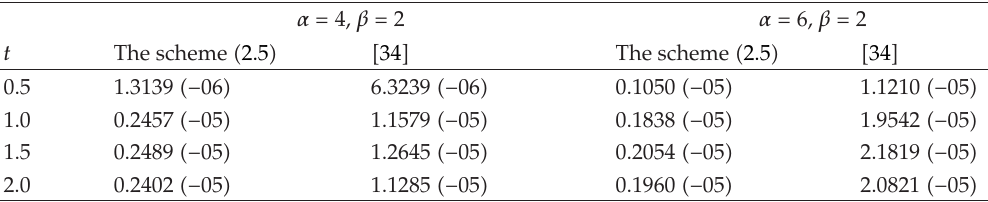
Table 8: RMS errors of scheme (cid:3) 2.5 (cid:4) and the scheme in (cid:6) 34 (cid:7) . α (cid:9) 4, β (cid:9)